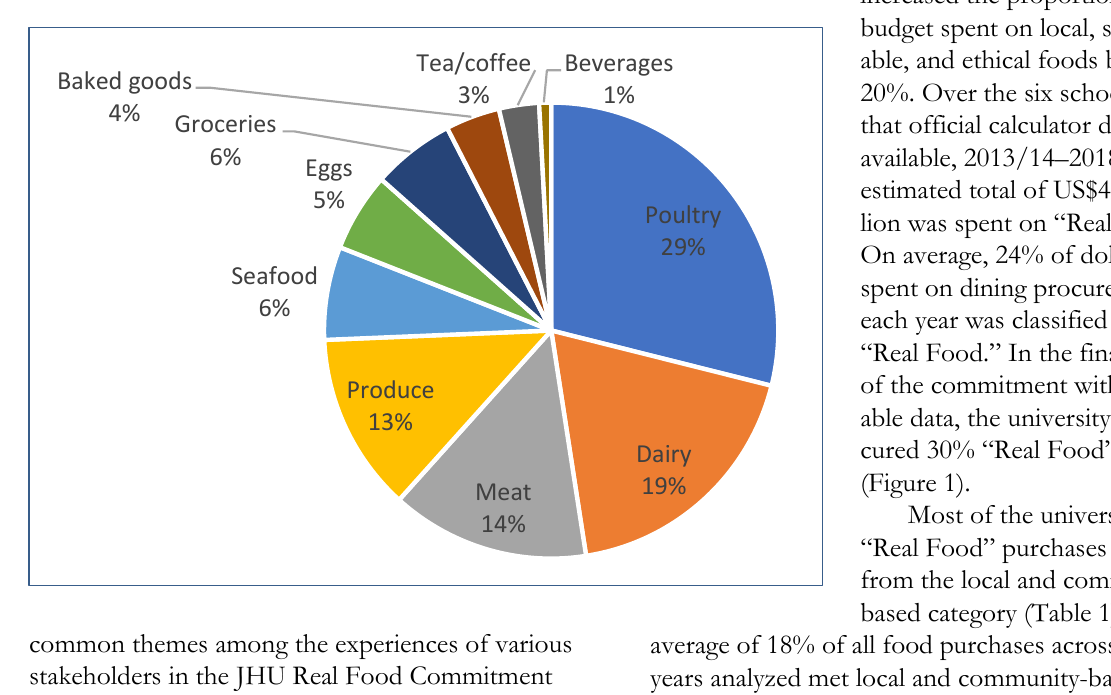
Figure 2. Average P ercentage of “Real Food” Purchases by Food